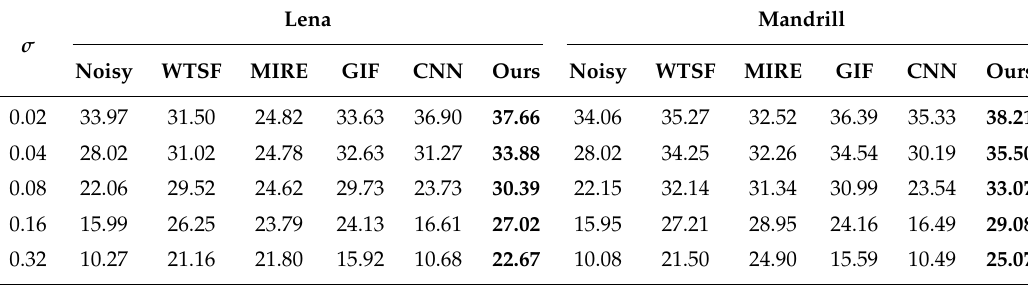
Table 2. Peak signal to noise ratio (PSNR) (dB) results for Lena and